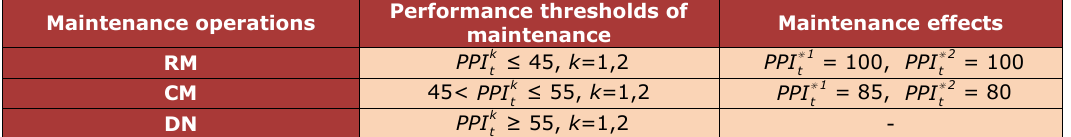
Table 1. Pavement maintenance operations and maintenance